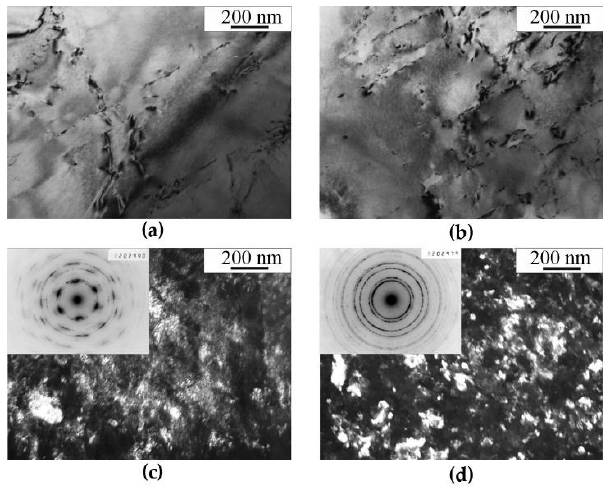
Figure 1. Structure of ( a , b ) quenched and ( c , d ) deformed FeMn 22 Cr 18 N 0.83 steel. Treatment: ( a , b ) quenching; ( c ) quenching + HPT of n = 3 rev. at 298 K; ( d ) quenching + HPT of n = 3 rev. at 573 K. ( a , b )—bright-field image, ( c , d )—dark-field images in the combined reflection (111) γ + (200) γ + Cr 2 N.